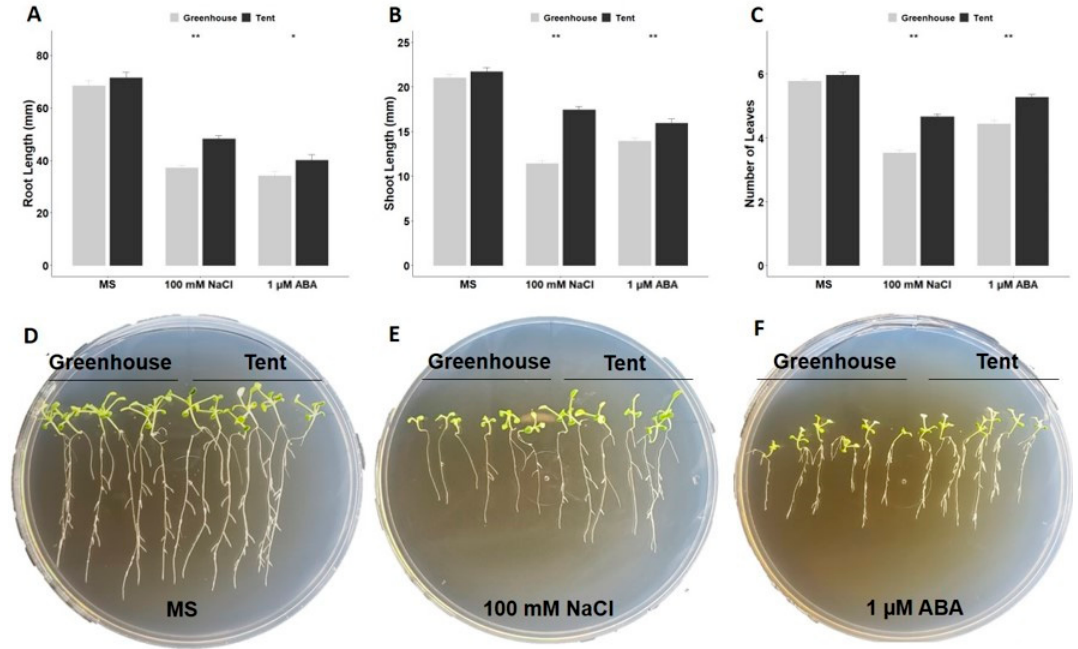
Figure 4. Effect of ABA and NaCl on the post-germination growth of petunia seeds harvested from greenhouse or tent plants. Uniformly germinated seeds were moved and placed on Murashige and Skoog (MS) medium, MS medium with 100 mM NaCl, or MS medium with 1 µM ABA. Root length ( A ), shoot length ( B ), and the number of leaves ( C ) for each treatment were measured after 14 days. ( D – F ) Representative image of seedlings’ growth after MS medium, 100 mM NaCl, and 1 µM ABA treatments, respectively. Six replications, with 6 seedlings for each replication ( n = 36 total), from greenhouse or tent plants were applied to each treatment. The vertical bars represent the mean ± standard error. * and ** Significant difference between seedlings originating from plants grown in the greenhouse and those grown in the tent under the same treatment condition at p < 0.05 and p < 0.01 ( t -test), respectively.